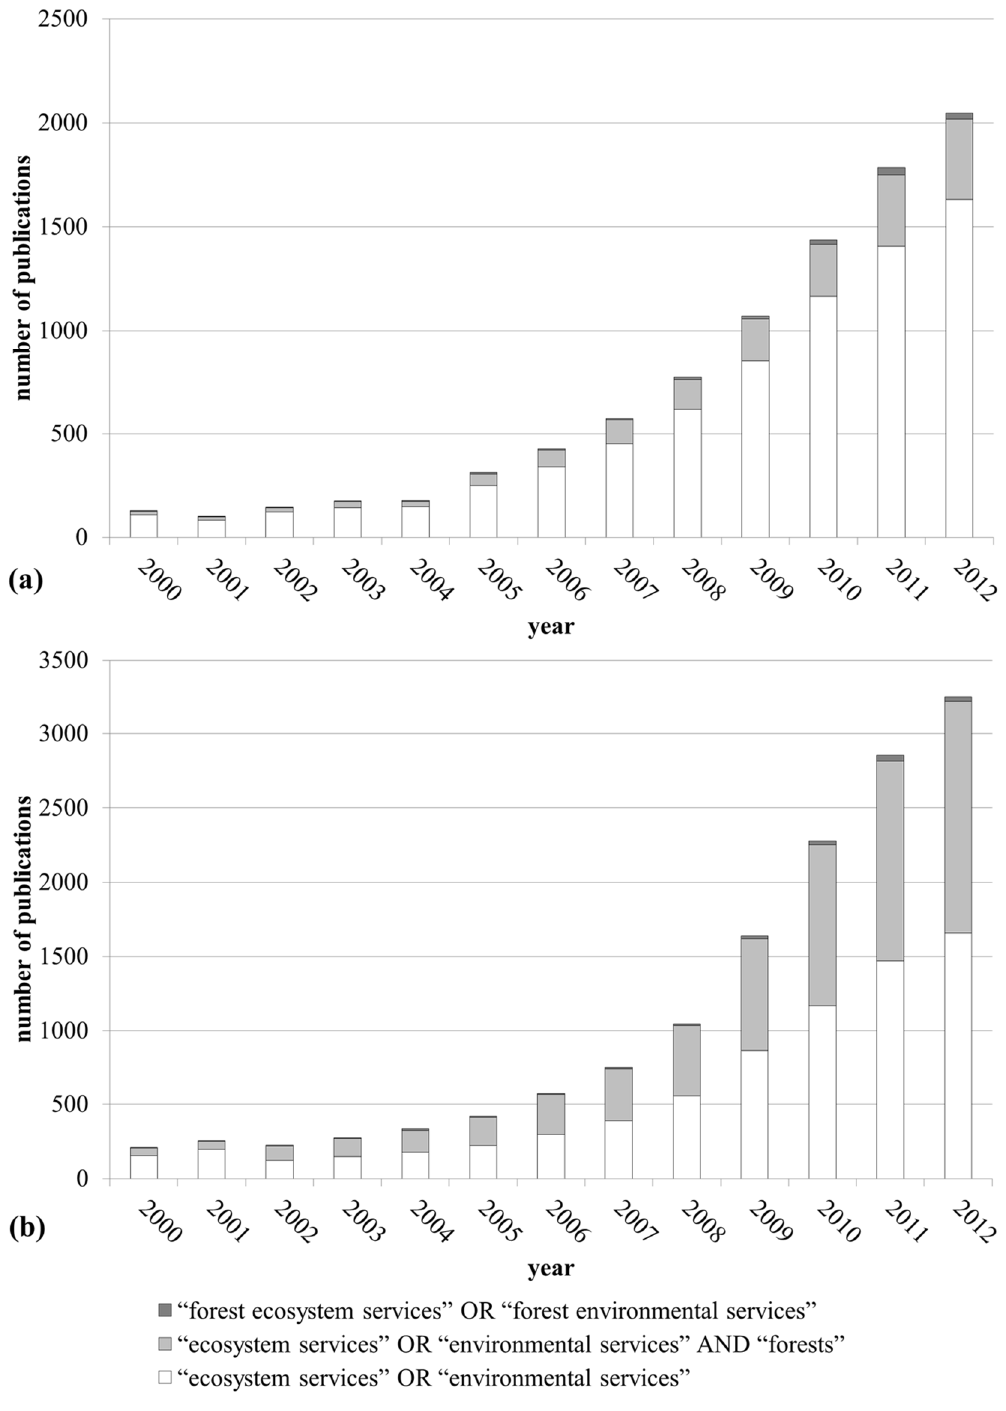
Figure 1. Trends of the number of publications per year for Review Section 1, as found by using SCOPUS ( a ) or ISI-Web of Science ( b